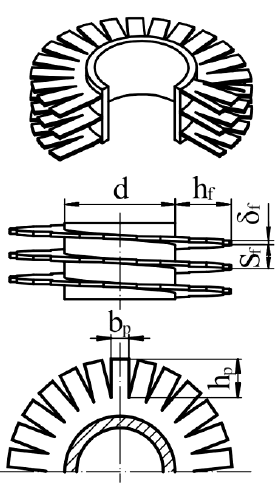
Fig. 1. Fragments of a tubes with punched